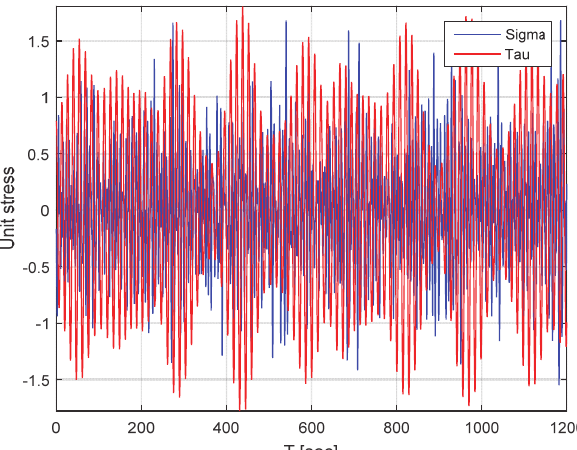
Figure 9: Example of two typical time traces for sigma and tau which have been used for PDMR based cycle counting.